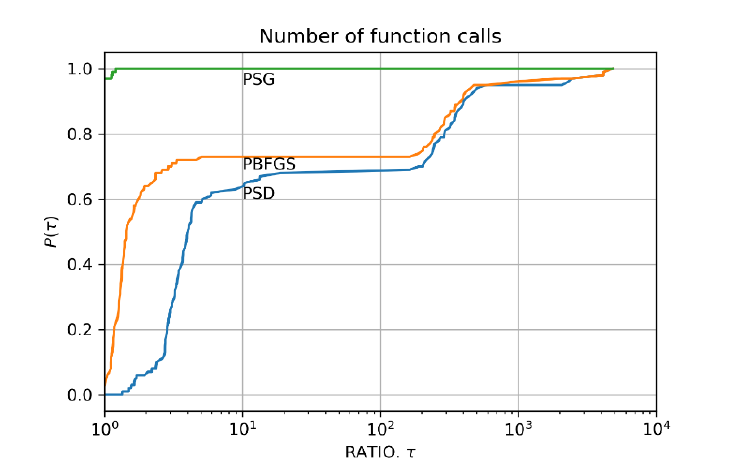
Fig. 2. Comparison of methods in terms of number of function